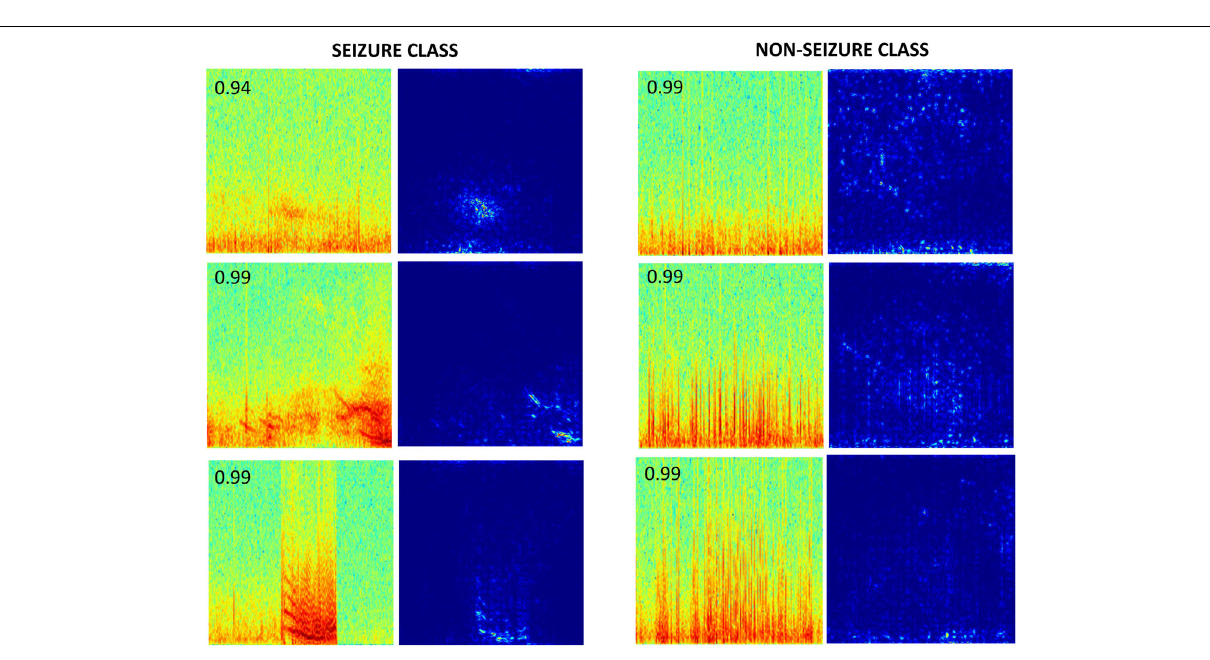
Frontiers in Neuroscience |